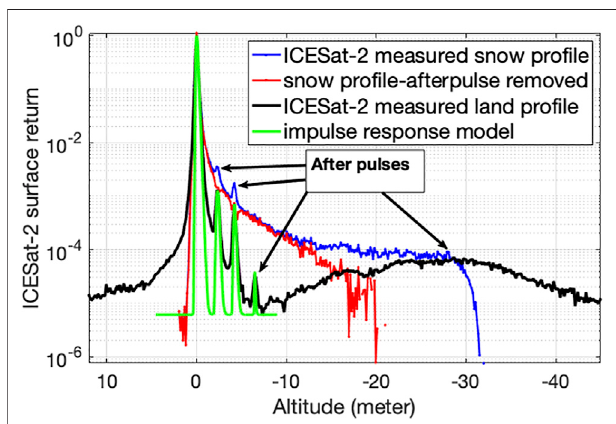
FIGURE 1 | Snow pro fi les measured by ICESat-2 before (blue) and after (red) deconvolution process, and its system impulse response from model (green) and land surface return (black). Altitude zero is the snow surface and altitudes below and above snow surface are negative and positive values,